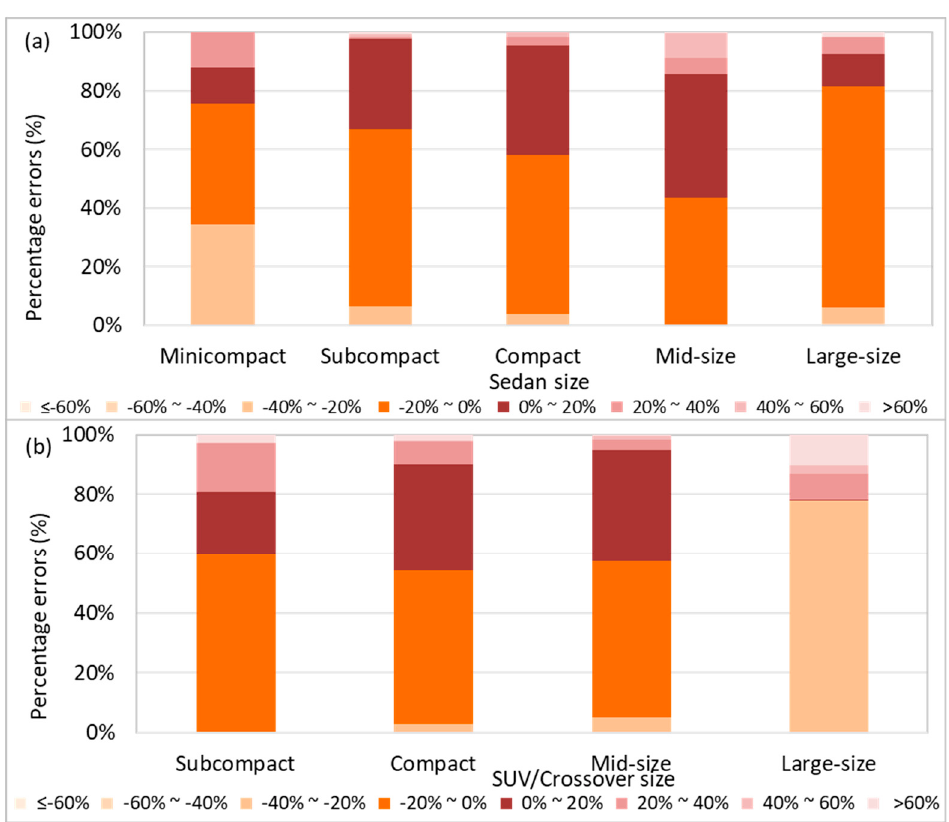
Figure 6. ( a ) Distributions of percentage errors in the sedan test dataset (sales-weighted) and ( b ) distributions of percentage errors in the SUV/crossover test dataset (sales-weighted).